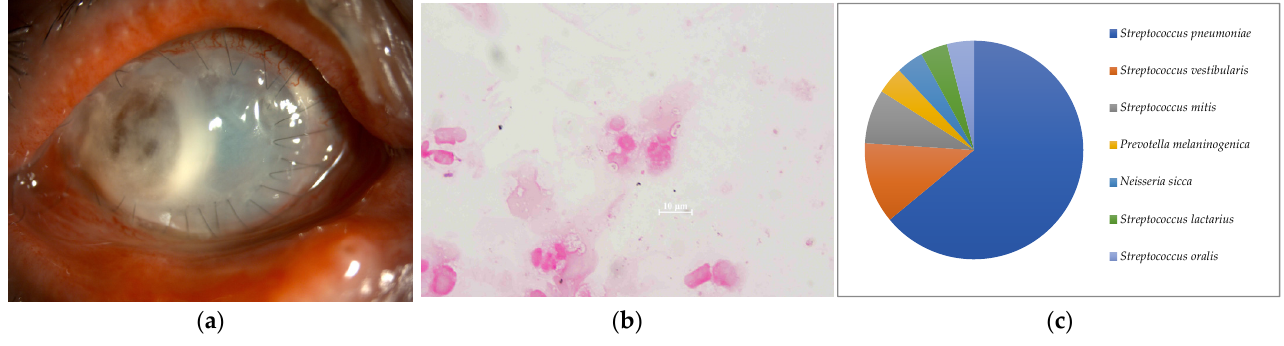
( c ) Figure 6. ( a ) Anterior segment photograph. Corneal infiltration and abscess were found in nasal cornea, suggestive of infectious keratitis. ( b ) Smear microscopy. Few Gram-positive rods are de- tected ( c ) Nanopore sequencing results (relative abundance) of Case 6. No bacterial species with a relative abundance greater than 50% was detected by MinION. ( a ) ( c ) Figure 7. ( a ) Anterior segment photograph. Corneal infiltration and corneal abscess were found, suggestive of infectious keratitis. ( b ) Smear microscopy. No organisms were detected by Gram stain- ing. ( c ) Nanopore sequencing results (relative abundance) of Case 7. An overwhelming majority of Staphylococcus aureus was detected by MinION.